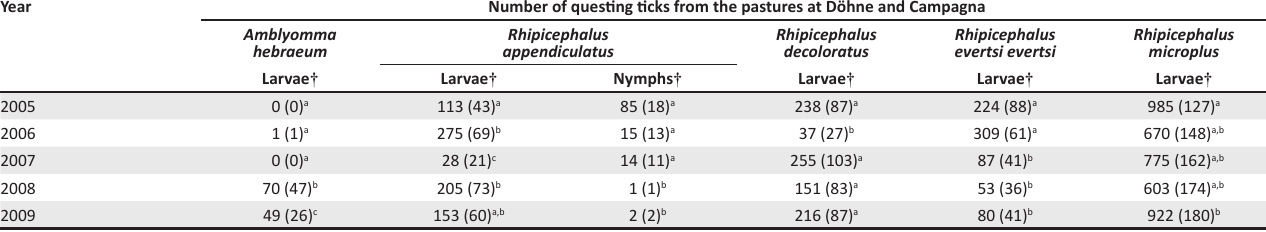
TABLE 2: Questing immature ticks of the five major species on the pastures at Döhne and Campagna during each year of the survey (2005–2009). Year Number of questing ticks from the pastures at Döhne and Campagna